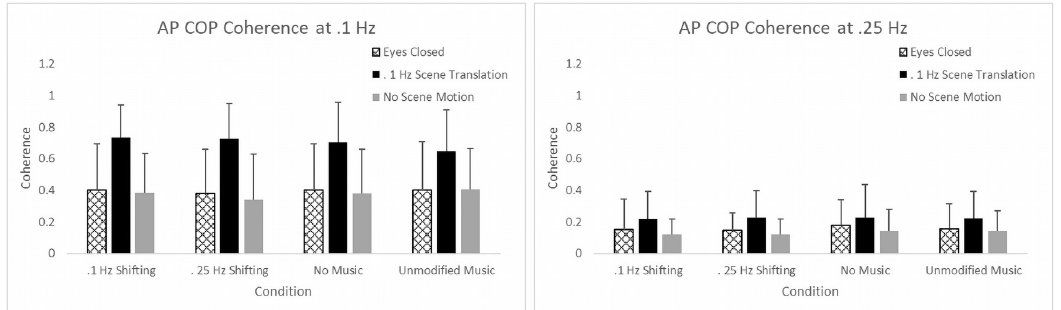
Fig 2. AP COP Coherence at 0.1 and 0.25 Hz. Subjects were exposed to combinations of visual conditions (eyes closed, viewing a static VR environment, viewing a VR environment with 0.1 Hz translation) and music conditions (no music, unmodified music, and music with volume shifting at 0.25 Hz and 0.1 Hz). AP COP coherence was highest when subjects experienced 0.1 Hz VR motion Music volume shifting at 0.1 Hz and 0.25 Hz appeared to have no more effect on coherence than the unmodified music and no music conditions. Error bars indicate the standard deviation.